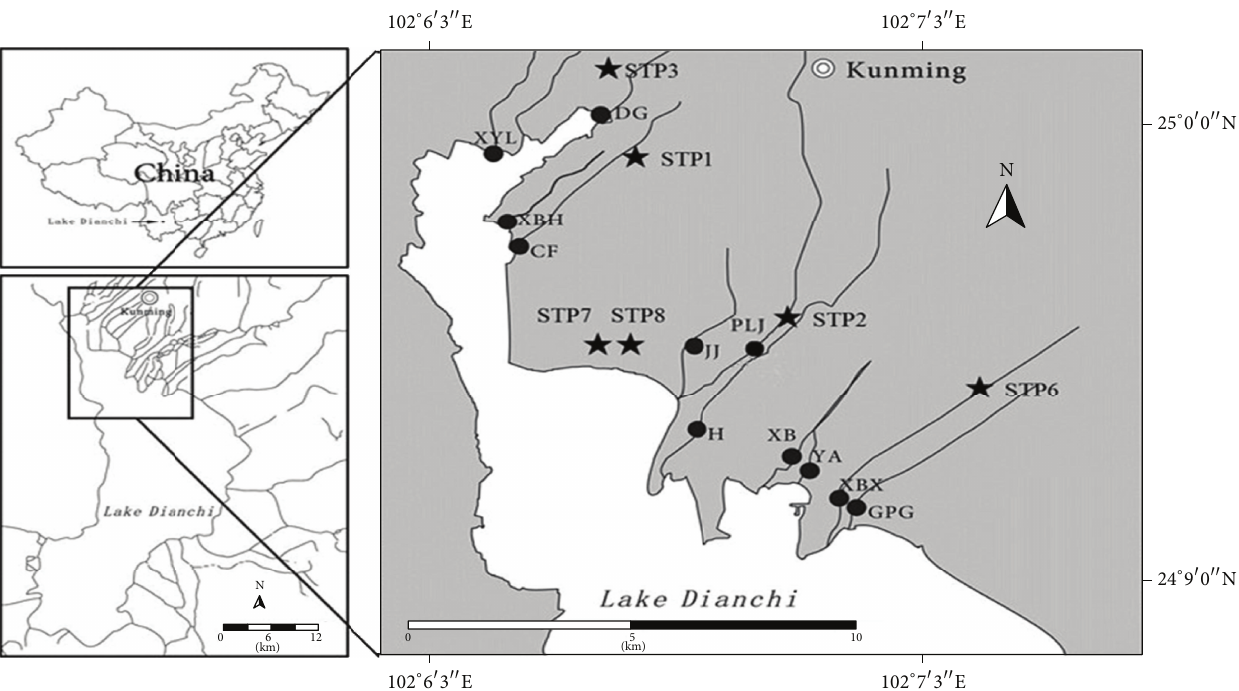
Figure 1: Sampling sites in stream inlets of Dianchi Lake. Black dots ( e ) are sampling sites; pentagrams ( 󳀅 ) are sewage treatment plants (STPs). Stream names: XBX = Xinbaoxiang, H = Haihe, XB = Xiaba, YA = Yaoan, JJ = Jinjia, GPG = Guangpugou, PLJ = Panlongjiang, XBH = Xibahe, CF = Chuangfang, DG = Daguang, and XYL =